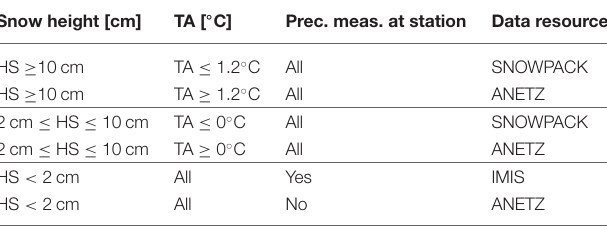
TABLE 2 | Summary of rules which are used to build the precipitation data sets. Snow height [cm] TA [ ◦ C] Prec. meas. at station Data resource